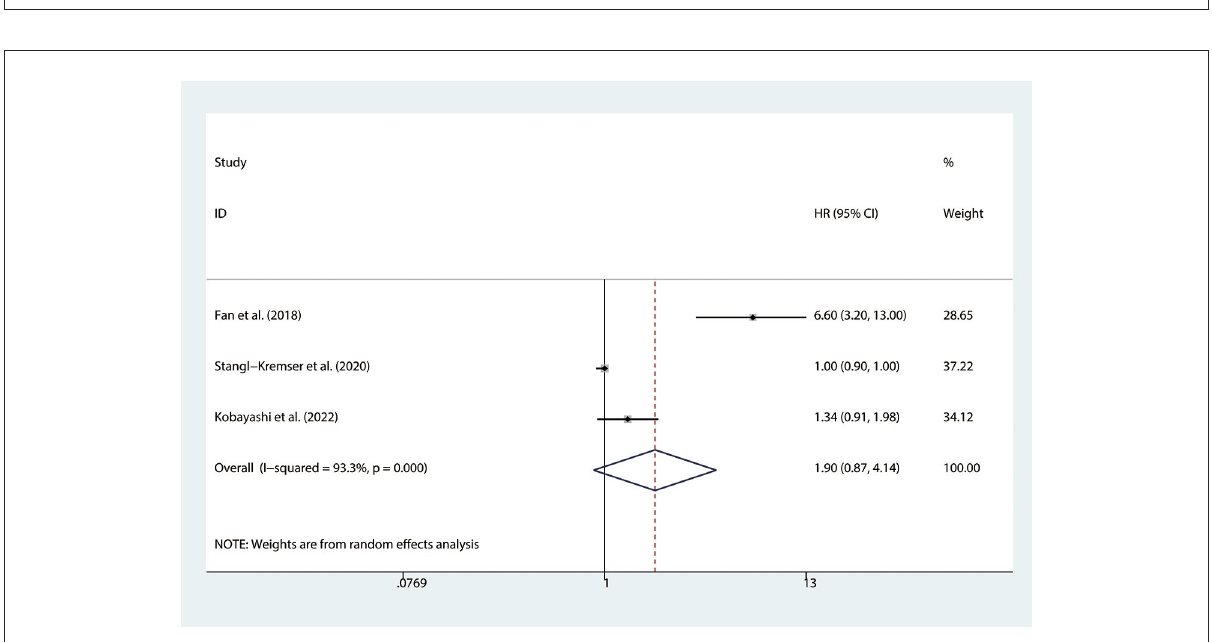
FIGURE3 Forest plot of the association between SII and PFS in mCRPC patients. SII, systemic immune-inflammation index; PFS, progression-free survival; mCRPC, metastatic castration-resistant prostate cancer.